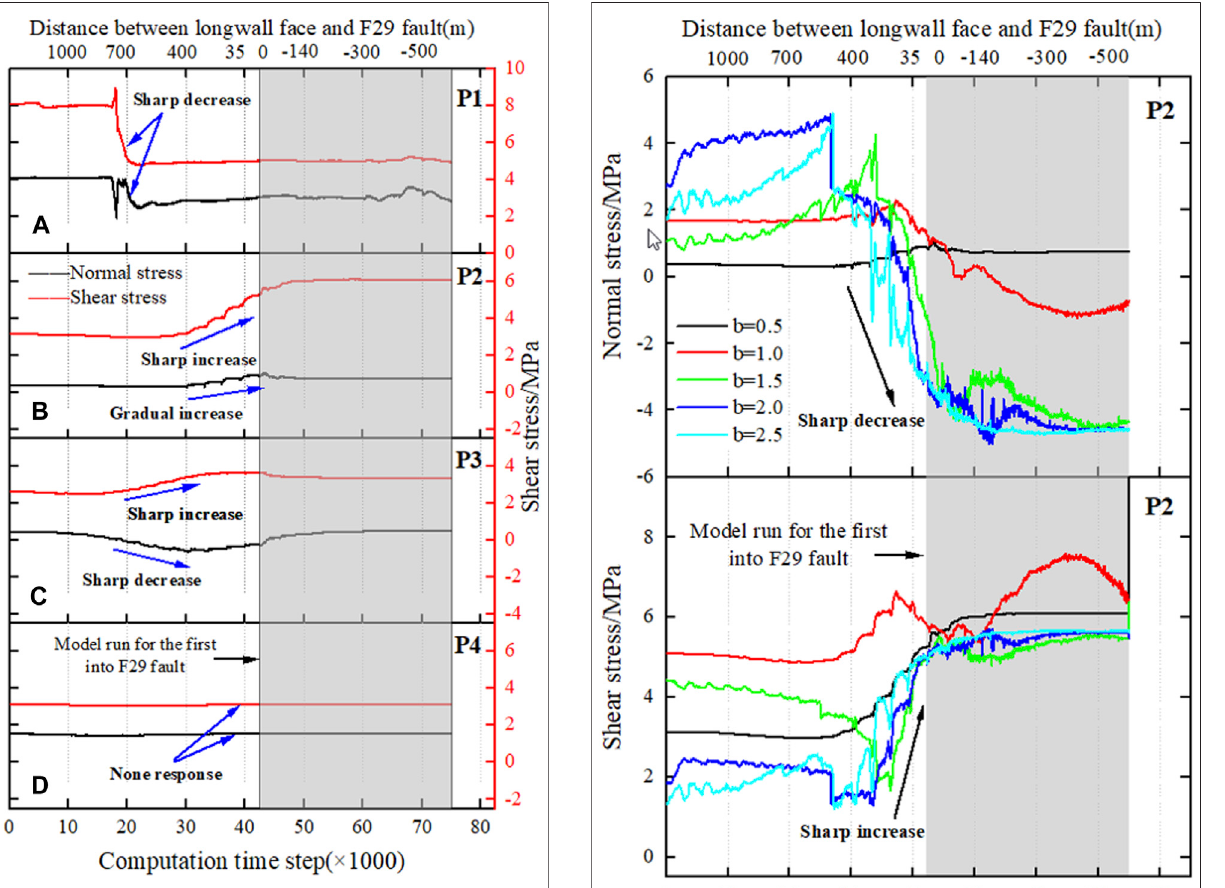
change laws of normal stress and shear stress at P2 located between the 401101 working face and the main entry group with mining advancement under different ground stress conditions (that is, when the lateral pressure coef fi cient b is 0.5, 1.0, 1.5, 2.0, and 2.5, respectively). As can be seen from Figure 8 , the evolution laws of normal stress and shear stress at this measurement point are basically consistent at different ground stress levels.